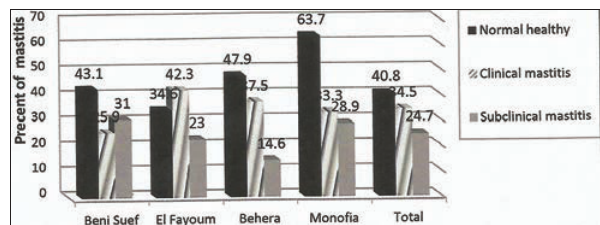
Figure-1: Prevalence of clinical and subclinical mastitis at different Governorates in Egypt.